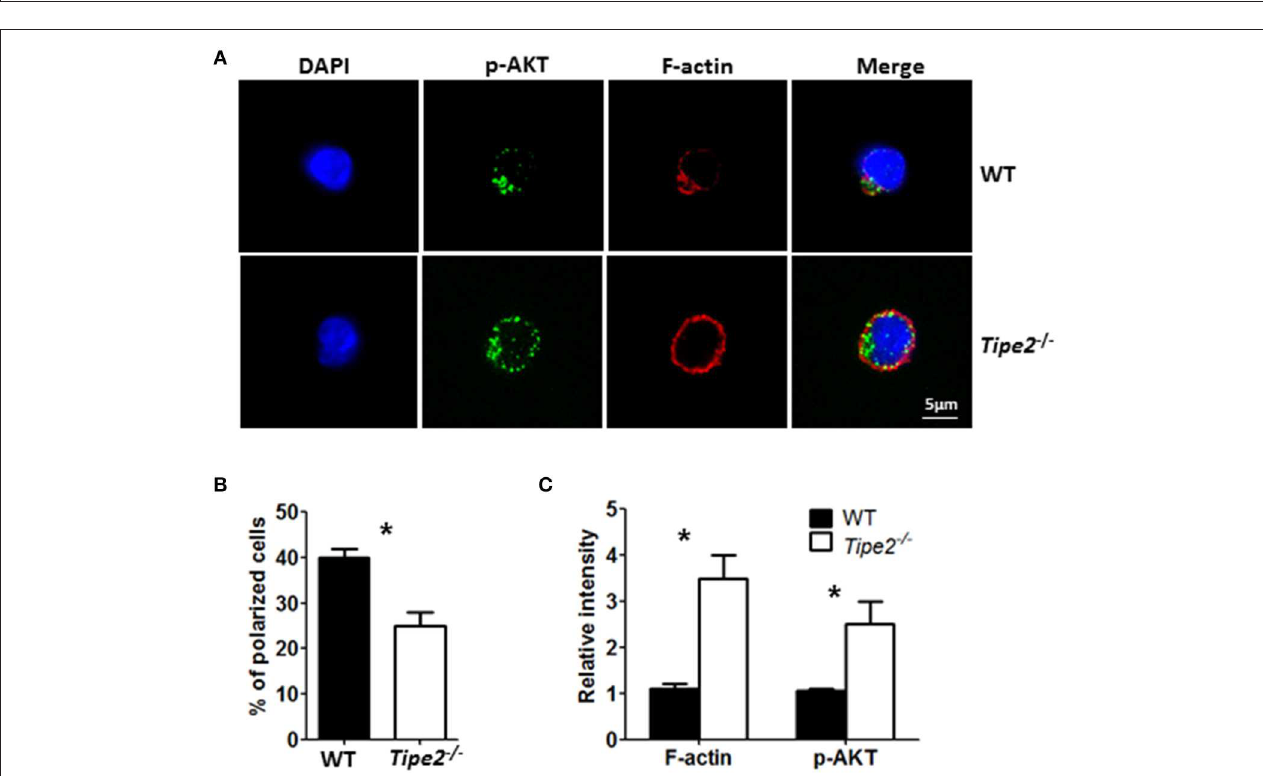
FIGURE 6 | TIPE2-deficient T cells are defective in leading-edge formation during chemotaxis. WT ( n = 5) and TIPE2-deficient ( n = 5) mice were treated as in Figure 1A and killed 3 days after the first IMQ treatment. Total T cells were isolated from inguinal lymph node and then subjected to point-source stimulation with IP10 at 1 µ g/ml for 3min at 37 ◦ C and stained with Phalloidin, anti-phospho-AKT antibody and DNA-binding dye DAPI. (A) The distributions of F-actin, phospho-AKT and DAPI in WT and TIPE2-deficient T cells were assessed by confocal microscopy. Data are representative of two separate experiments. (B) The percentages of polarized WT and TIPE2-deficient T cells were calculated. (C) The total intensity of F-actin and p-AKT was calculated using ImageJ. For (B,C) , data are pooled results from two separate experiments with more than 50 cells analyzed per genotype. * P <